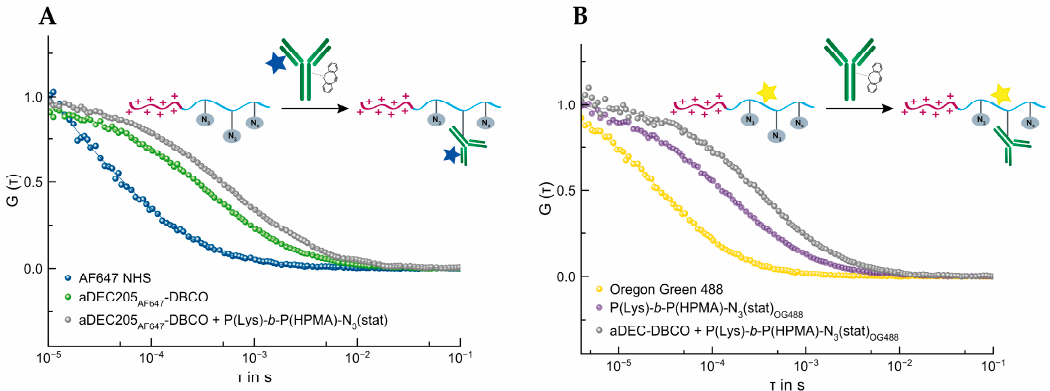
Figure 5. FCS: ( A ) SPAAC of aDEC205 AF647 -DBCO and P(Lys)- b -P(HPMA)-N 3 (stat): blue line: AF647 NHS: R h = 0.76 nm; green line: aDEC205 AF647 -DBCO: R h = 6.0 nm; grey line: conjugate of aDEC205 AF647 -DBCO and P(Lys)- b -P(HPMA)-N 3 (stat): R h = 10.0 nm (78%). ( B ) SPAAC of aDEC205-DBCO and P(Lys)- b -P(HPMA)-N 3 (stat) OG488 : yellow line: Oregon Green 488: R h = 0.58 nm; purple line: P(Lys)- b -P(HPMA)-N 3 (stat) OG488 : R h = 4.3 nm; grey line: conjugate of aDEC205-DBCO and P(Lys)- b -P(HPMA)-